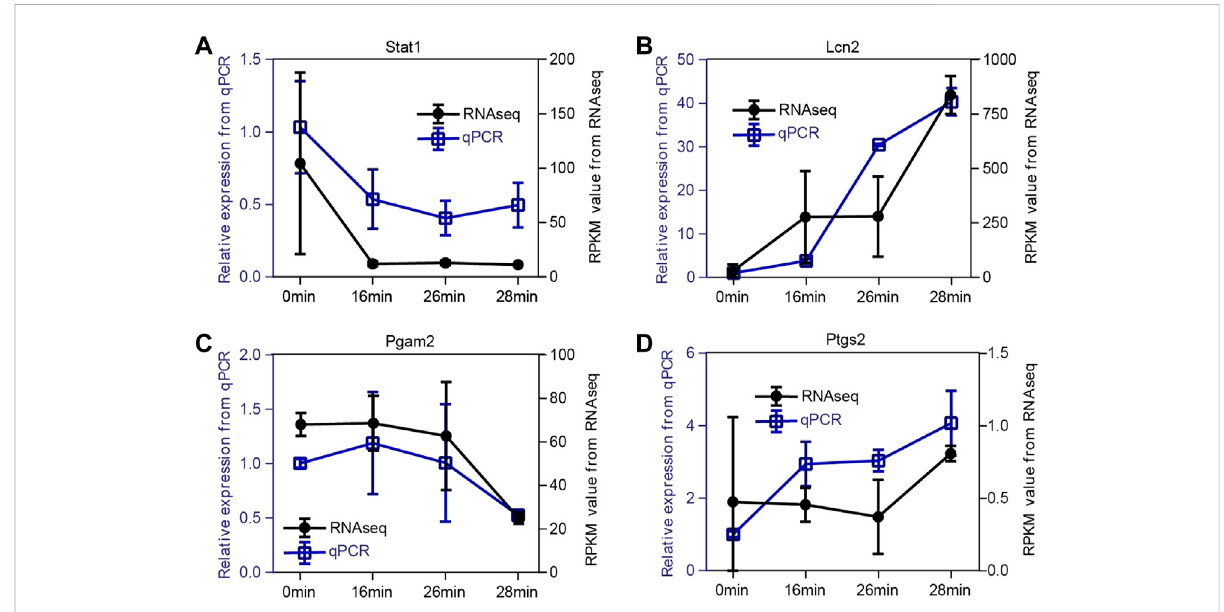
FIGURE 8 Validation of expression patterns of four representative key genes. (A – D) The expression level of Stat1 (A) , Lcn2 (B) , Pgam2 (C) , and Ptgs2 (D) . To verify the dynamic change of expression level, we selected four representative genes to perform the qPCR assay. The expression patterns of Stat1, Lcn2, Pgam2, and Ptgs2 are highly consistent between RNA-seq data and qPCR results. The x-axis represents the time points. The right black y-axis represents the RPKM value from RNA-seq data, and the left blue y-axis indicates the relative expression level of qPCR